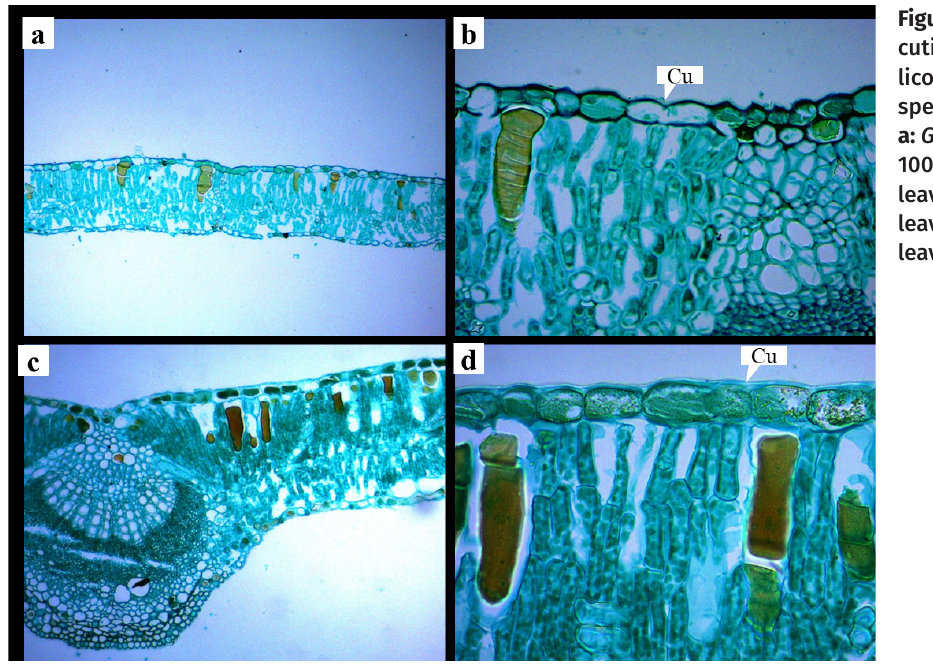
Figure 4. Leaf blade and cuticle thickness in two licorice ( Glycyrrhiza ) species. a: G. uralensis leaves 100×; b: G. uralensis leaves 400×; c: G. inflata leaves 100×; d: G. inflata leaves 400×; Cu: cuticle.